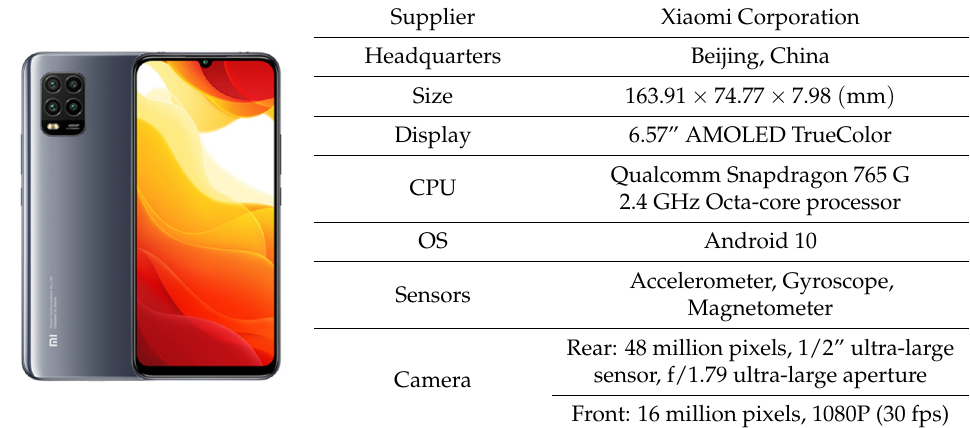
Table 3. Specifications of Xiaomi Mi 10 Lite.